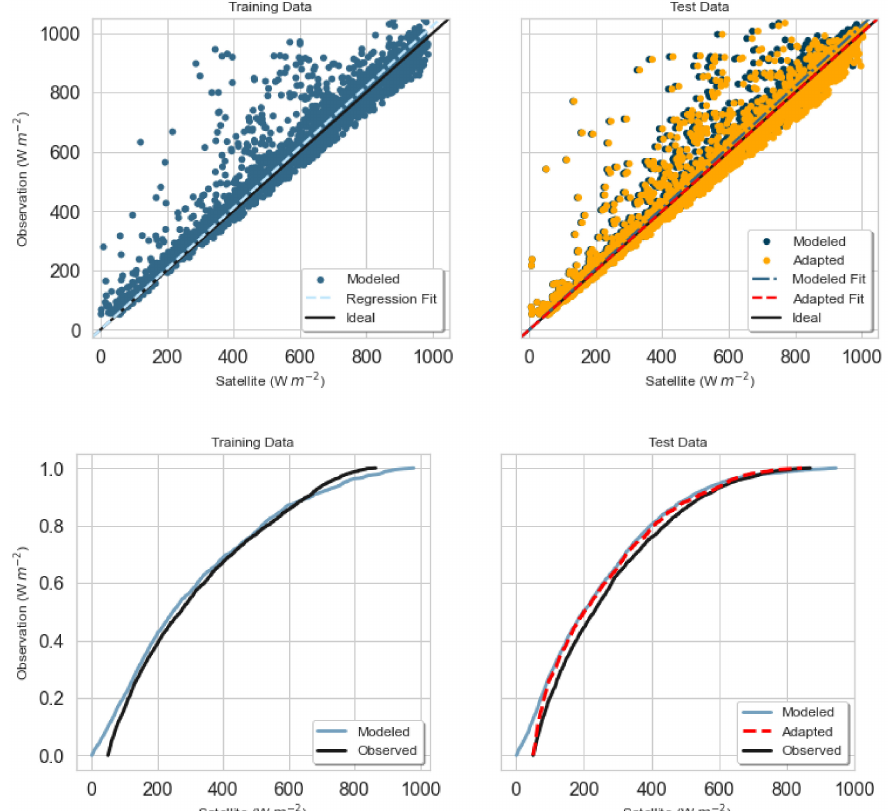
Figure 2. Visual representation of regressive ( upper panels ) and distribution mapping ( lower panels ) techniques of